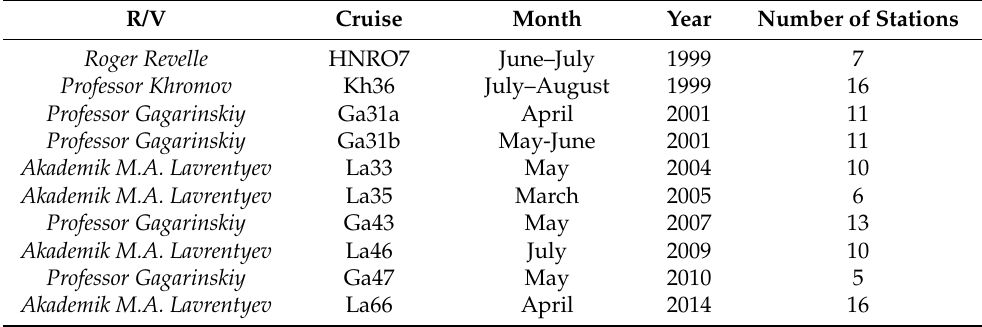
Table 1. Metadata of hydrochemical observations along meridional sections 132 ◦ 20 (cid:48) E and 134 ◦ 00 (cid:48) E in 1999–2014.